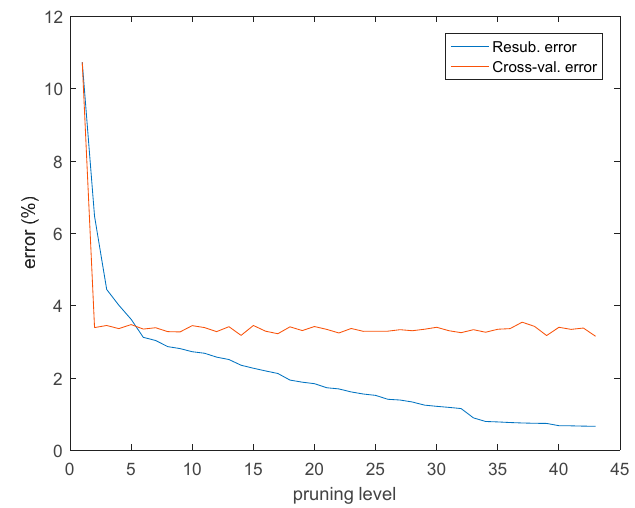
Figure 6. Evaluation of the optimal pruning on the basis of the cross-validation error.